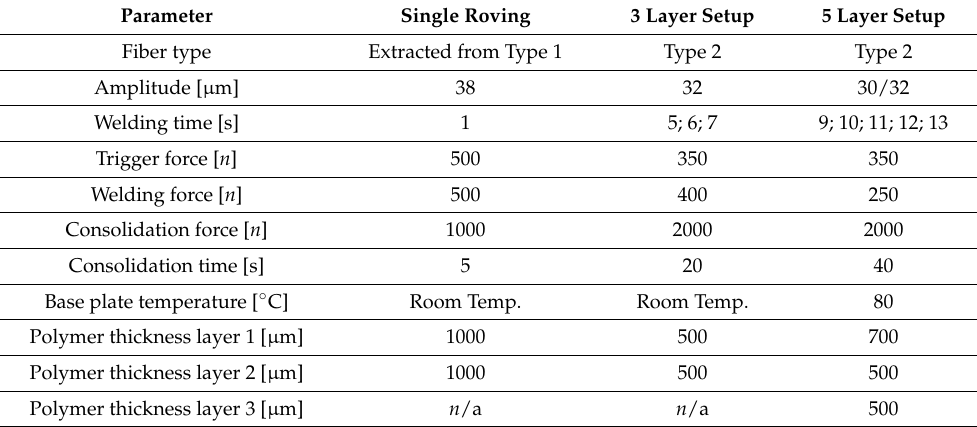
Table 1. Chosen parameter settings for single roving, 3- and 5-layer setups.